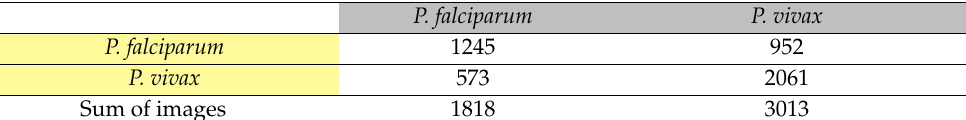
Table 5. Confusion matrices for image and patient-level of our four pipelines using the P. falciparum and the P. vivax dataset. Each matrix is the summation of five-fold cross-validation on patient-level. Gray represents actual values, whereas yellow represents predicted values. The accuracy for each confusion matrix is mentioned in the caption of each subfigure, measured as the ratio between the sum of the diagonal elements over the total number of images (on image level) or patients (on patient